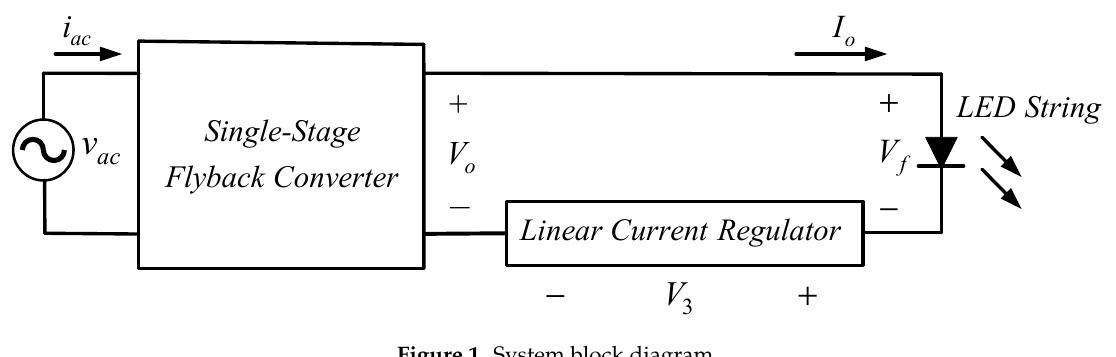
Figure 1. System block diagram.